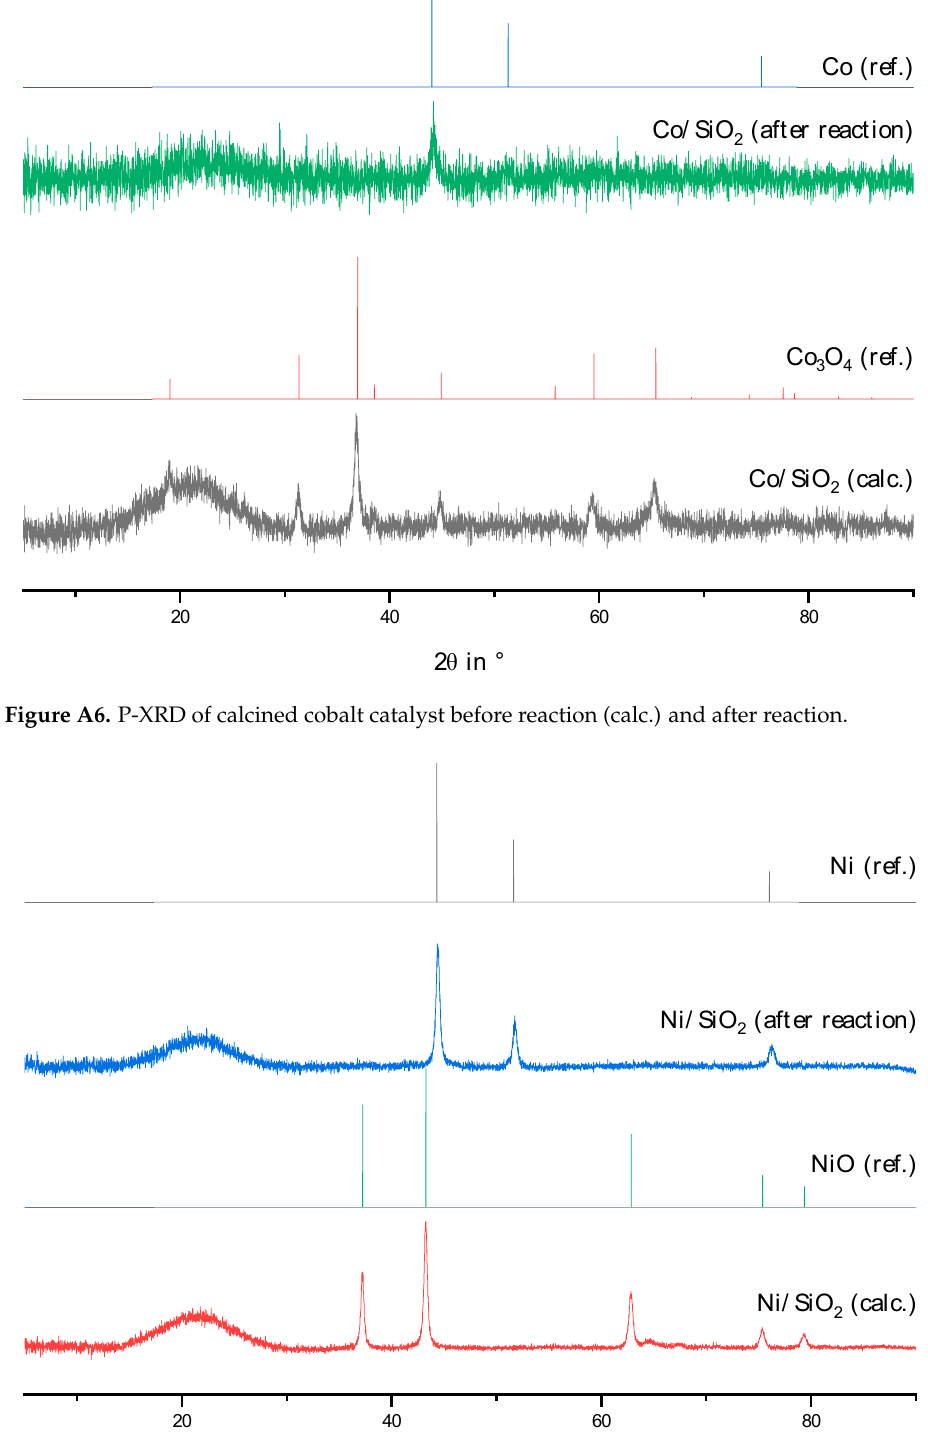
Figure A7. P-XRD of calcined nickel catalyst before reaction (calc.) and after reaction.